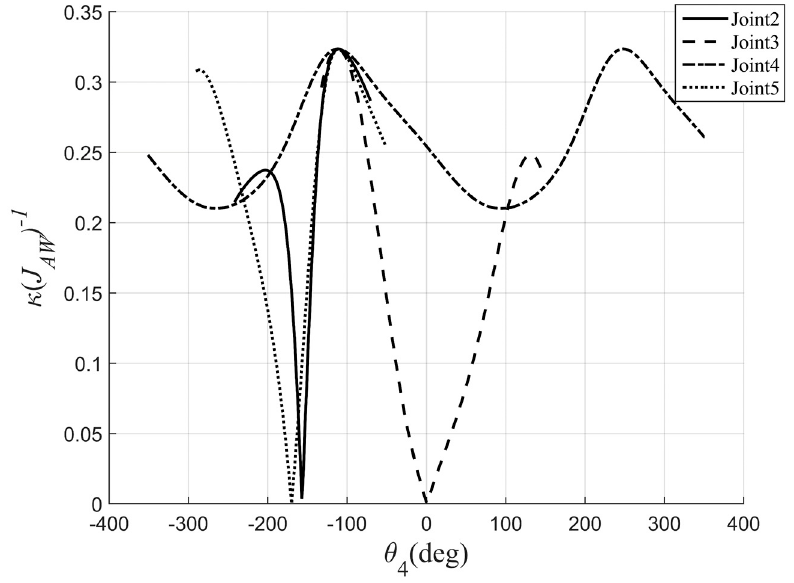
( ) 1 κ − J in the 4th joint space. AW